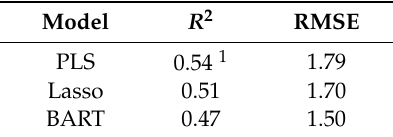
Table 3. Model selection monthly PM 2.5 . PLS—partial least squares; BART—Bayesian additive regression trees; RMSE—root-mean-square